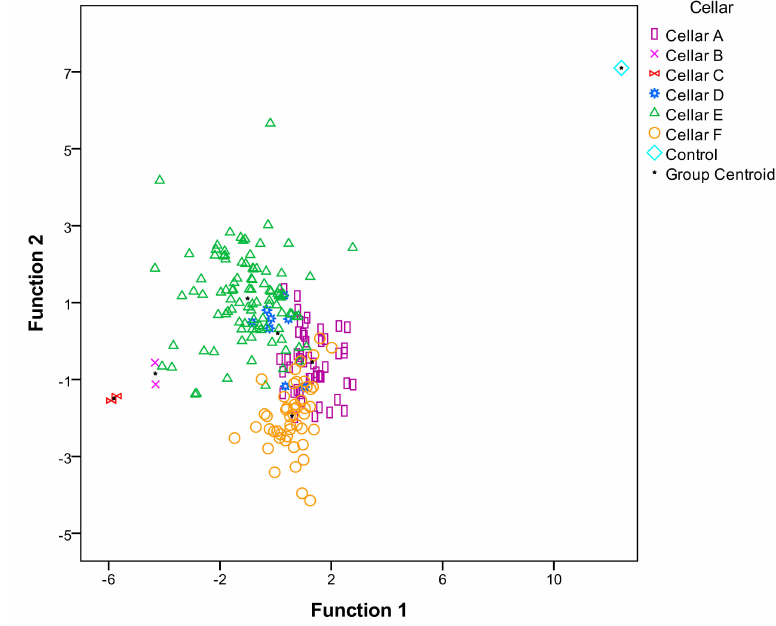
Figure 2. Application of discriminant analyses of the OAV data of volatile compounds studied in wines, classifying the samples by cellar of